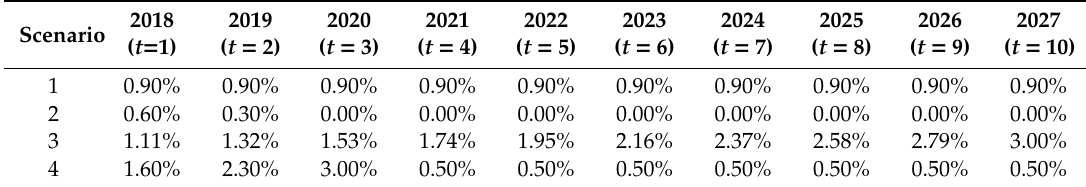
Table 5. Overview of interest rate scenarios for the basic interest rate r bas , t